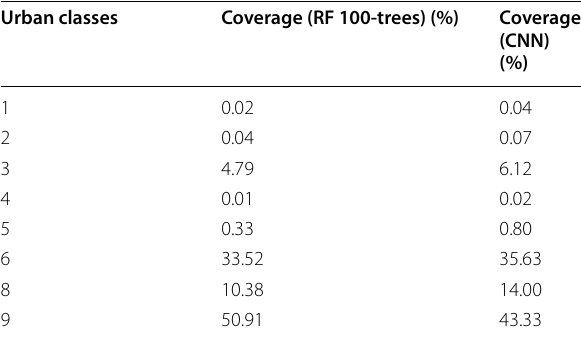
Table 3 Percentage coverage of urban LCZ classes in Austin classified by RF 100‑trees and CNN Urban